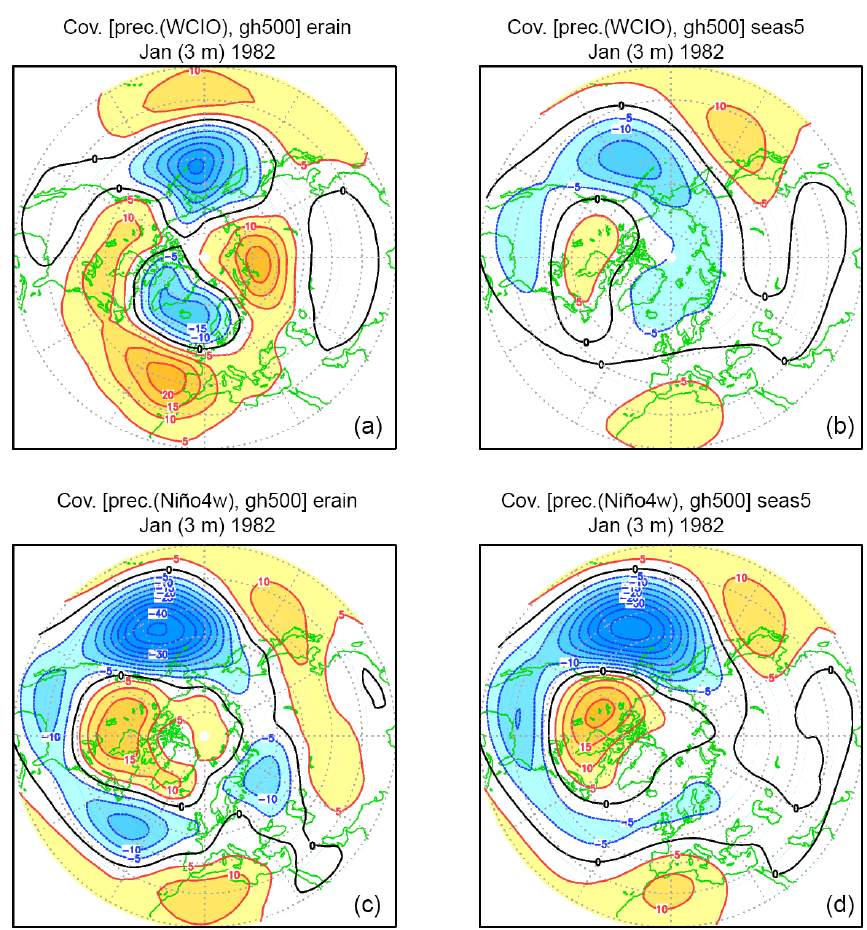
Figure 14. Covariances between normalised DJF rainfall anomalies in the western and central Indian Ocean (WCIO, a, b ) and Niño 4w (c, d) regions, and 500hPa height anomalies over the northern extratropics for 1981 to 2016. (a, c) From GPCP v2.3 rainfall and ERA-Interim geopotential height data; (b, d) from SEAS5 re-forecasts. SEAS4 results are shown in Fig. 6 in